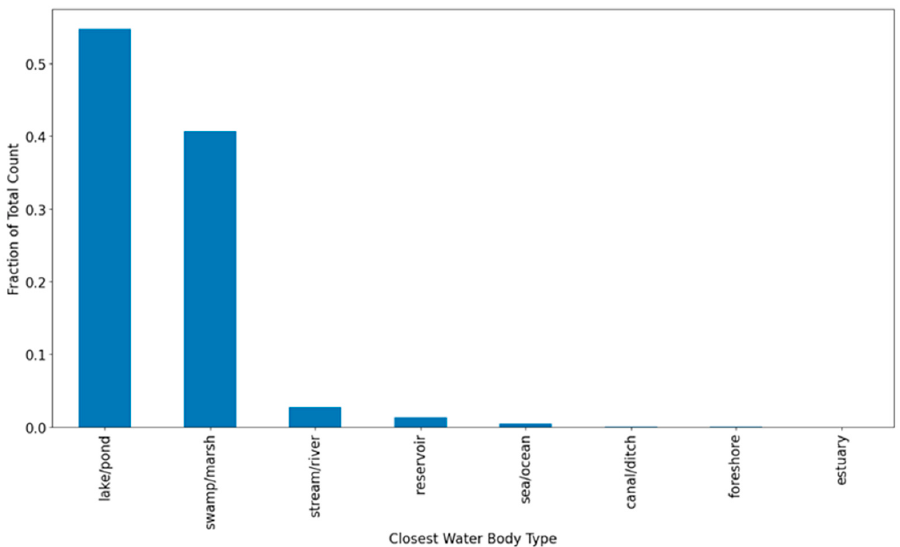
Figure 18. Closest bodies of water to Carolina Bay detections by fraction of total detection count.